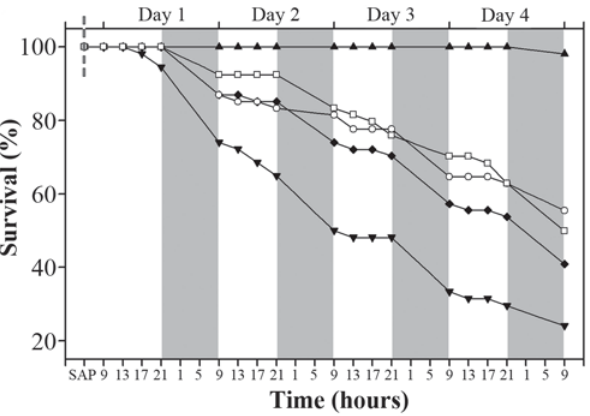
Fig. 3. Temporal variation of prey species survival (%) in response to P. corruscans piscivory. White square = Prochilodus lineatus , white circle = Astyanax altiparanae , inverted black triangle = Cichla piquiti , black diamond = Oreochromis niloticus , black triangle = Ictalurus punctatus (empty and full symbols correspond to native and invasive species respectively). Vertical gray bands correspond to dark